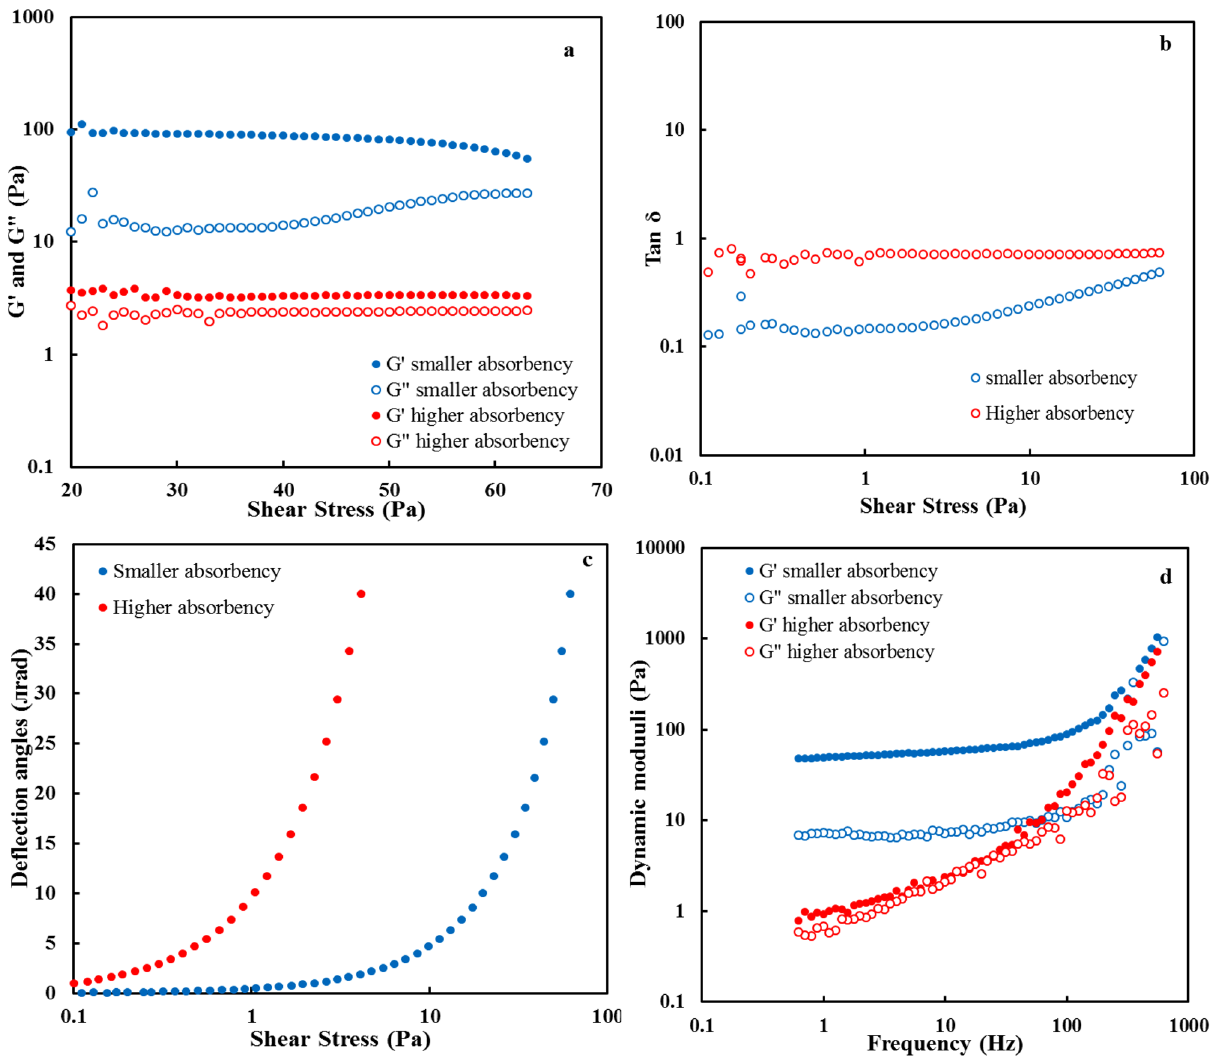
Figure 4. Viscoelastic properties of the superabsorbents swollen in DW: ( a ) G’ and G" as a function of shear stress, ( b ) tan δ versus shear stress, ( c ) deflection angle versus shear stress, and ( d ) G’ and G" versus frequency for the swelling